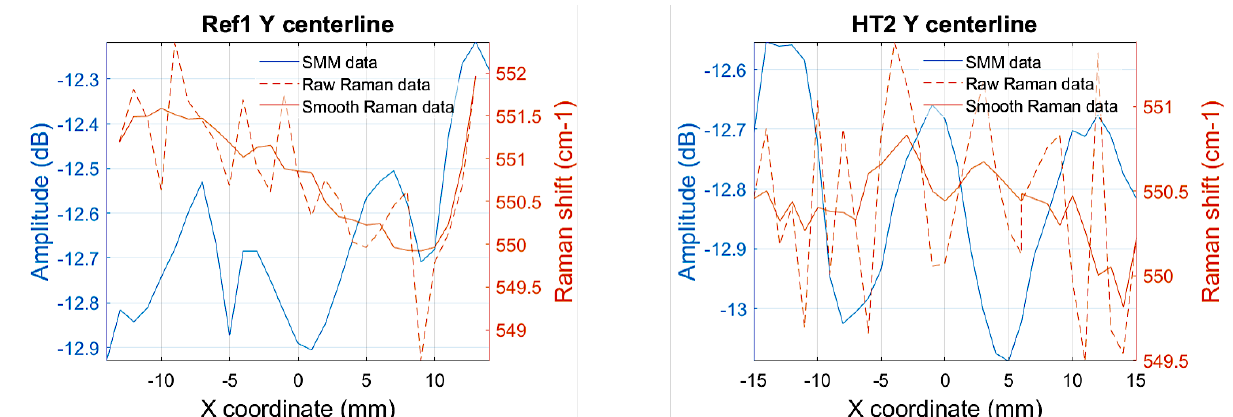
Figure 5. Correlation of stress measurements along Y centerlines for the two